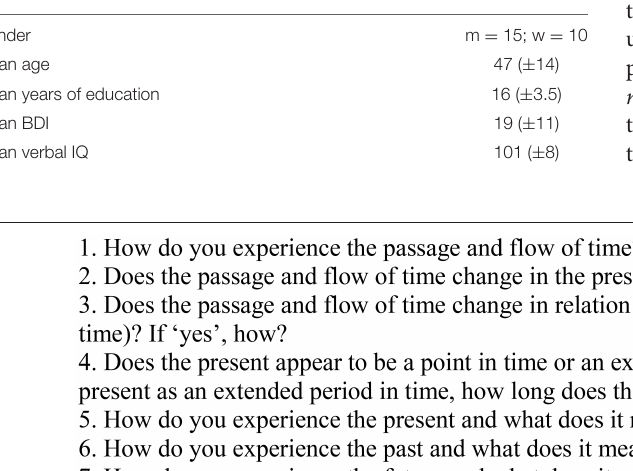
TABLE 2 | Demographics (Standard Deviation in brackets).